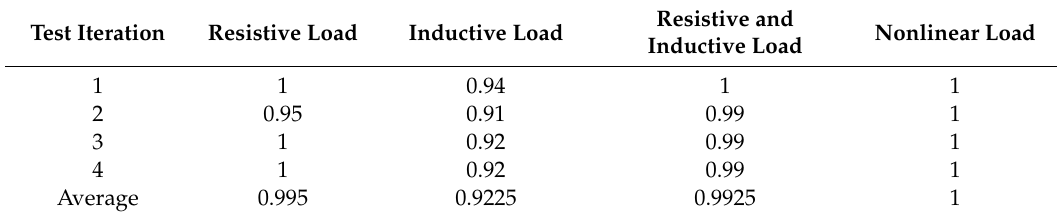
Table 3. Test results of different loads.